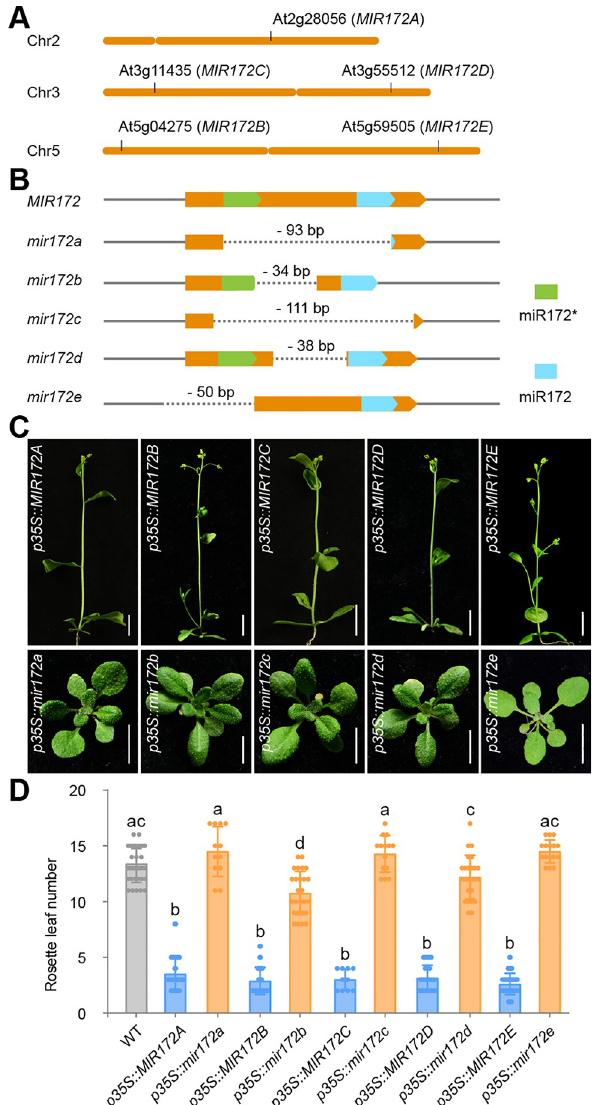
Fig 1. Generation of MIR172 mutants by CRISPR-Cas9 technology. (A) Location of the MIR172 genes on Arabidopsis chromosomes. The short and long arms of chromosomes 2, 3, and 5 are shown. (B) The genomic structure of the MIR172 gene loci in WT and the mir172 mutants. Orange, stem-loop of MIR172 gene; green, miRNA � ; blue, miRNA. (C) Validation of the mir172 mutants. The WT or mutated versions of MIR172 genes were cloned and overexpressed in WT. Please note that overexpression of the WT version of MIR172 led to early flowering time phenotype. Scale bars represent 1 cm. (D) Flowering time measurement. The number of rosette leaves was counted. Plants were grown at 22˚C in long days. The statistically significant differences are determined by ordinary one-way ANOVA ( p < 0.05). See also S4 Table. The data underlying this figure are included in S1 Data. CRISPR, clustered regularly interspaced short palindromic repeats; miRNA, microRNA; sgRNA, single guide RNA; WT, wild type.